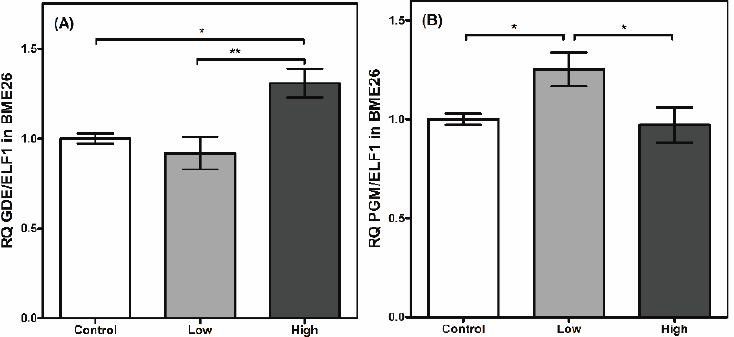
Figure 6. Glycogen degradation has a transcriptional control in BME26 cells. Transcriptional analysis of glycogen debranching enzyme ( A ) and phosphoglucomutase ( B ) in embryonic Rhipicephalus microplus cells (BME26) in response to glucose treatment. Control: cells maintained with 50 mM of glucose; Low: cell maintained without glucose addition; and High: cells maintained with 100 mM of glucose. The experiment was performed with three independent biological samples in three experimental replicates each ( * p < 0.05; ** p < 0.001,